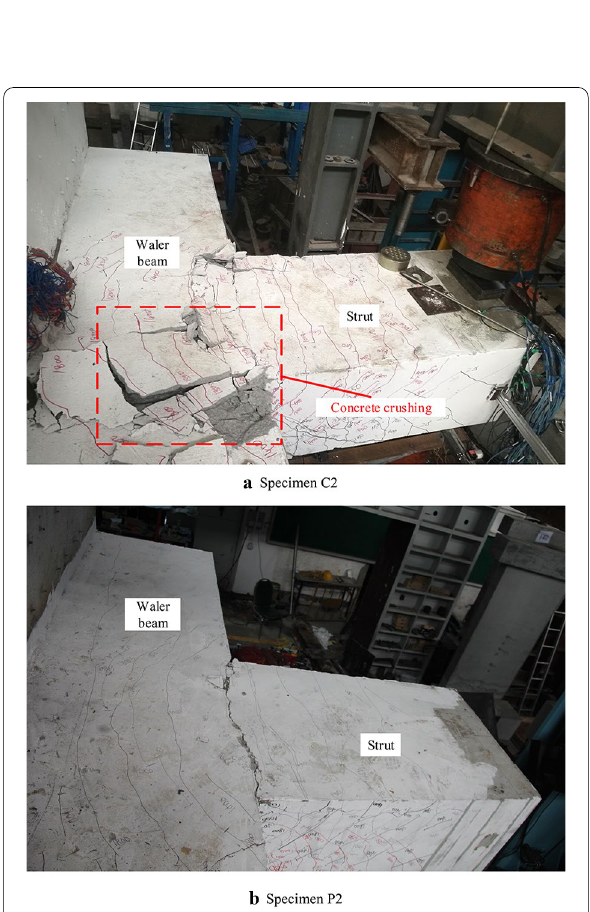
Fig. 17 Ultimate fracture patterns of specimens C2 and P2.